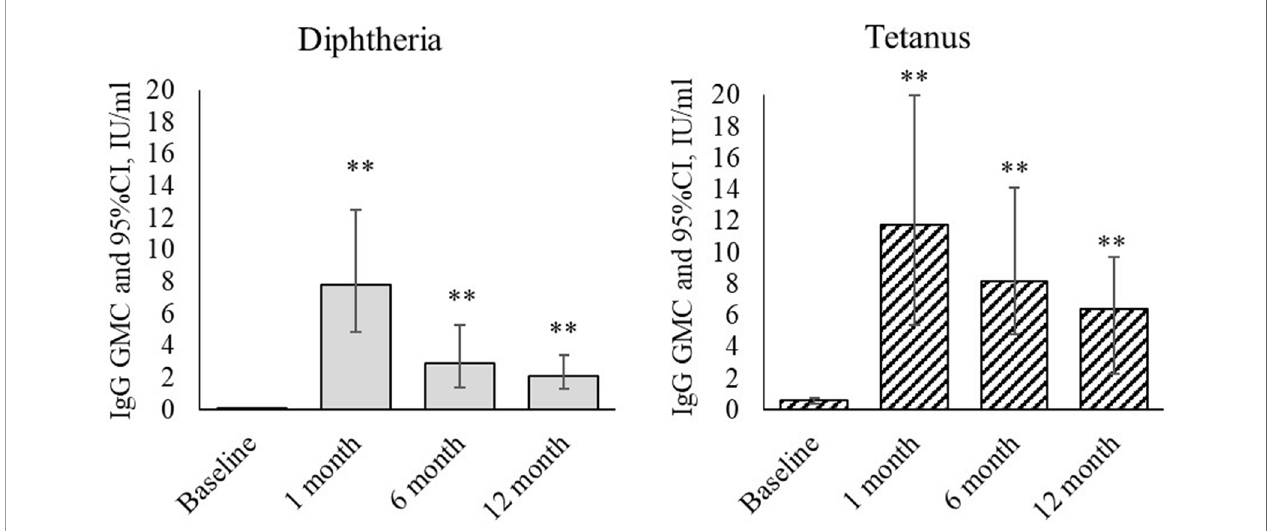
FIGURE 1 | Dynamics of IgG antibodies against diphtheria and tetanus during revaccination with ADS-m toxoid (n = 26). Geometric mean concentrations and their 95% con fi dence interval (GMC [95% CI]). **p < 0.001 - differences from the pre-revaccination value (we used the post-hoc Demsar test with a statistically signi fi cant Friedman omnibus